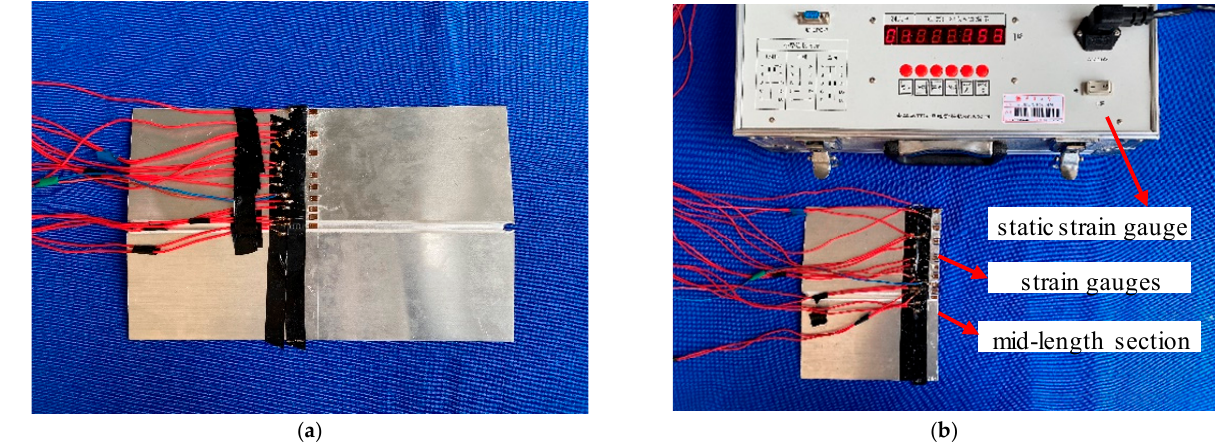
Figure 12. Test images of the strip cutting method: ( a ) before cutting; ( b ) after cutting.